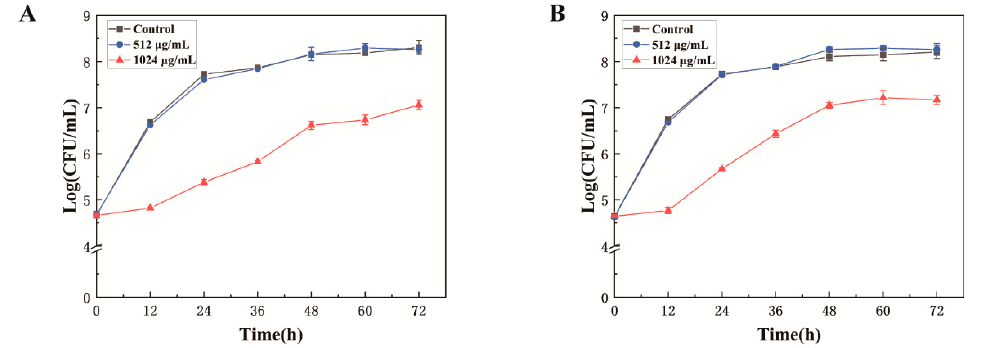
Figure 9. Effect of MEL-A on the growth of L. monocytogenes in whole milk ( A ) and skimmed milk ( B ) at room temperature (25 °C). Error bars are standard deviations ( n = 3).